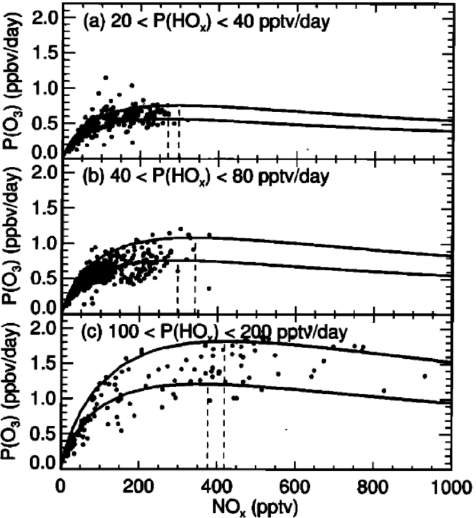
Figure 17. Empirical observations of ozone production rate as a function of NO x concentrations (parts per trillion volume, pptv), for three ranges of primary HO x production: ( a ) 20–40 pptv/day, ( b ) 40–80 pptv/day, and ( c ) 100–200 pptv/day. Solid lines represent the range limits from model calculations. Dashed lines depict the NO x level that induces peak ozone response. Reprinted with permission from Jaeglé et al. [5]. Copyright 2022, American Geophysical